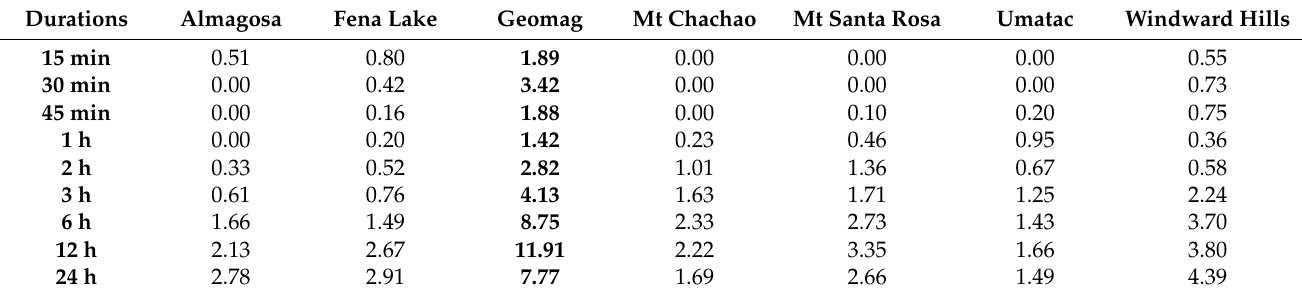
Table 3. RRMSE Values.